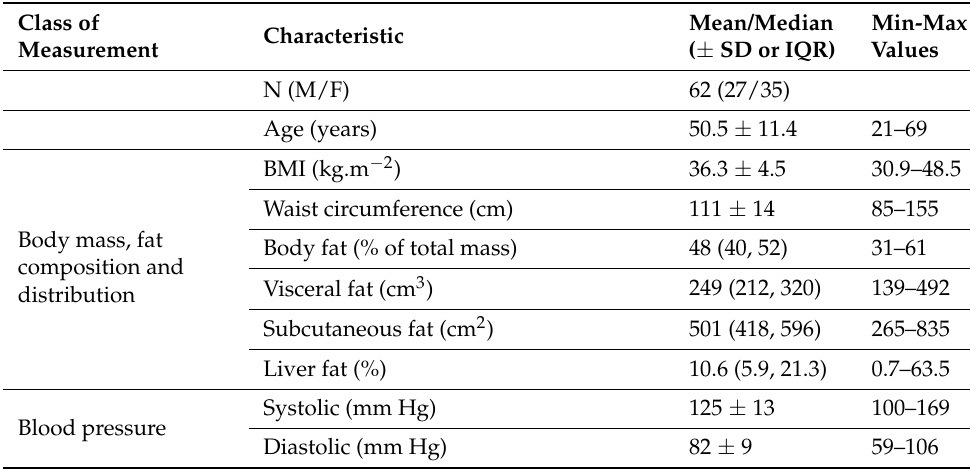
Table 1. Clinical and metabolic characteristics of the